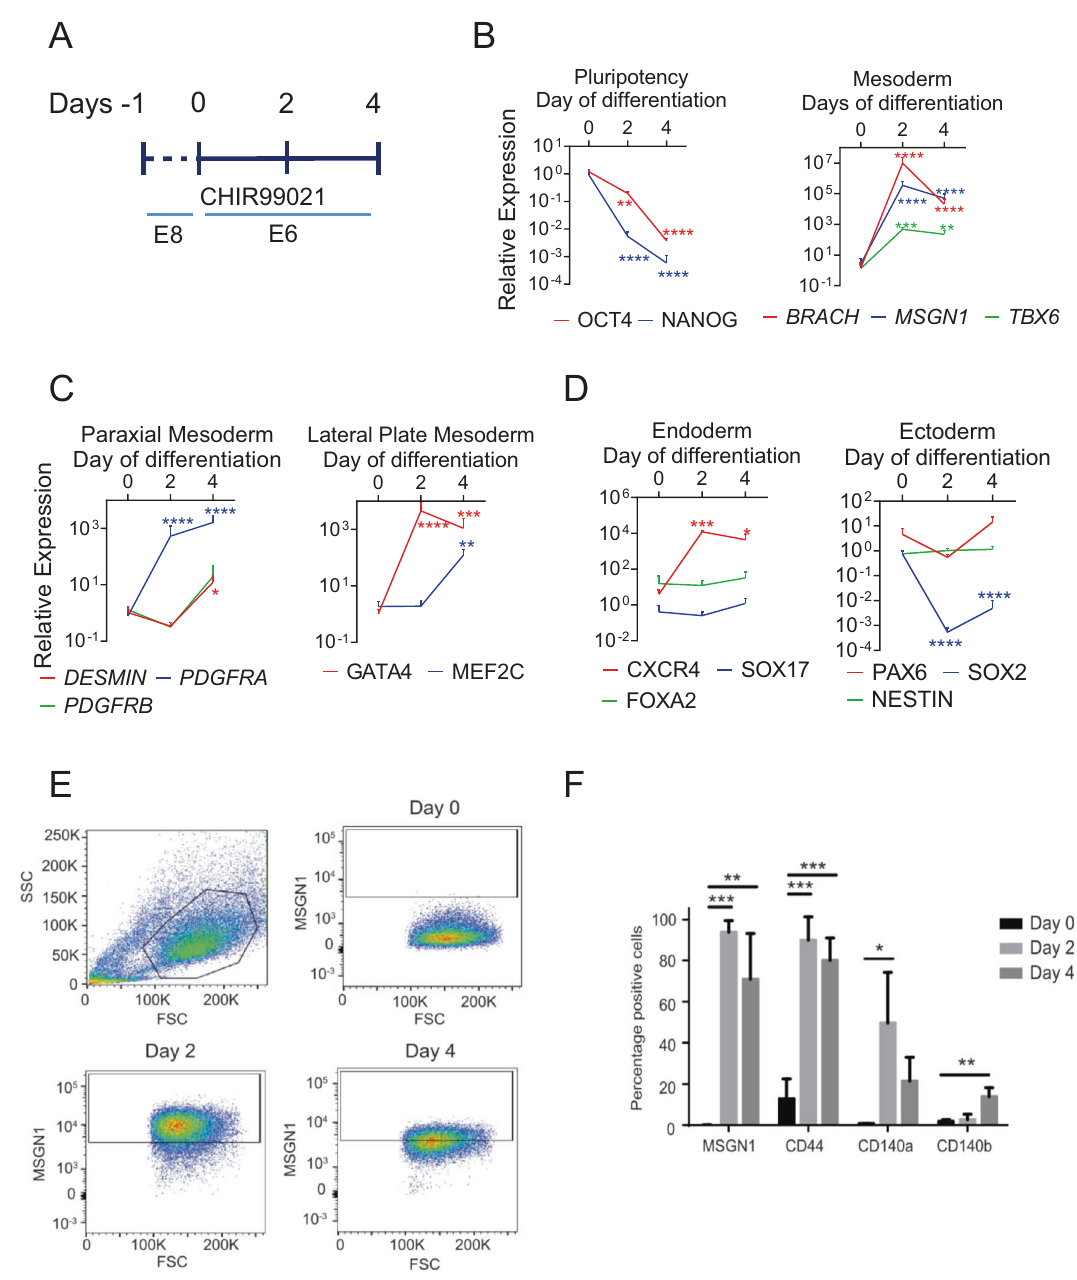
Fig. 1 Mesodermal progenitors can be derived trough a chemically de fi ned monolayer approach. A Schematic overview of the protocol to differentiate induced pluripotent stem cells towards mesodermal progenitors. B – D Gene expression of markers for pluripotency, early and late mesoderm, ectoderm, and endoderm during mesoderm differentiation. E FACS analysis of Mesogenin1 (MSGN1) during differentiation using a MSGN1 – 2A-Venus reporter line. F Percentage of MSGN1, CD44, and CD140A/B positive cells during differentiation, based on FACS analysis. *